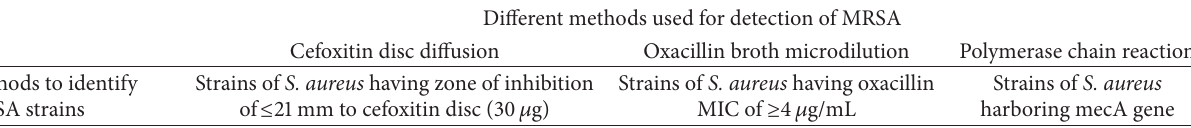
Table 1: Comparison of the phenotypic and genotypic methods for detection of MRSA.